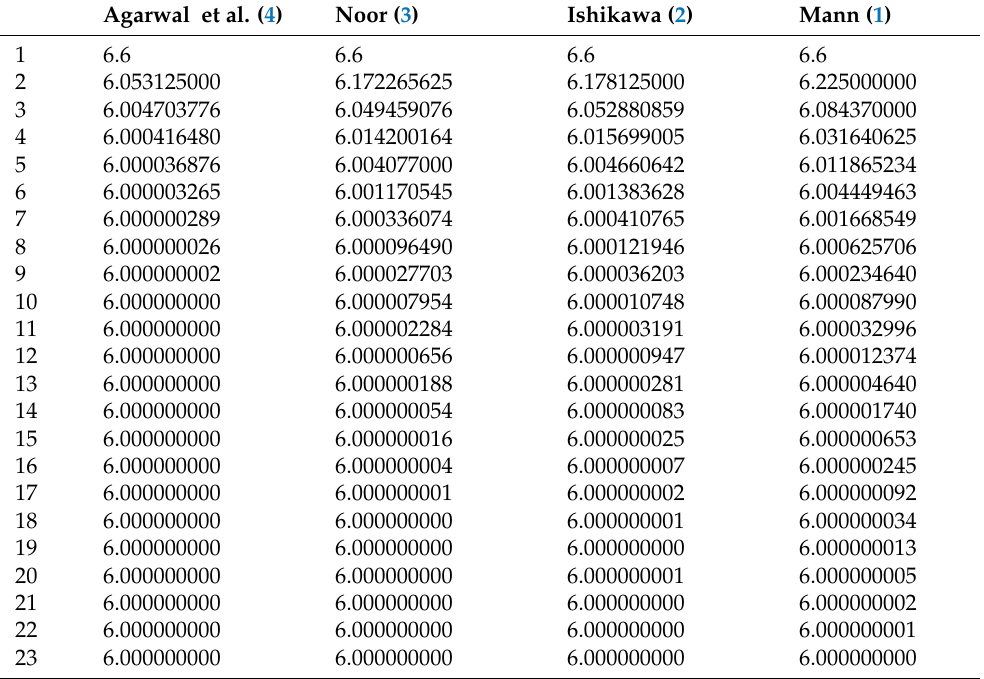
Table 2. Sequences generated by the different iterative processes for the RSTN selfmap T given in Example